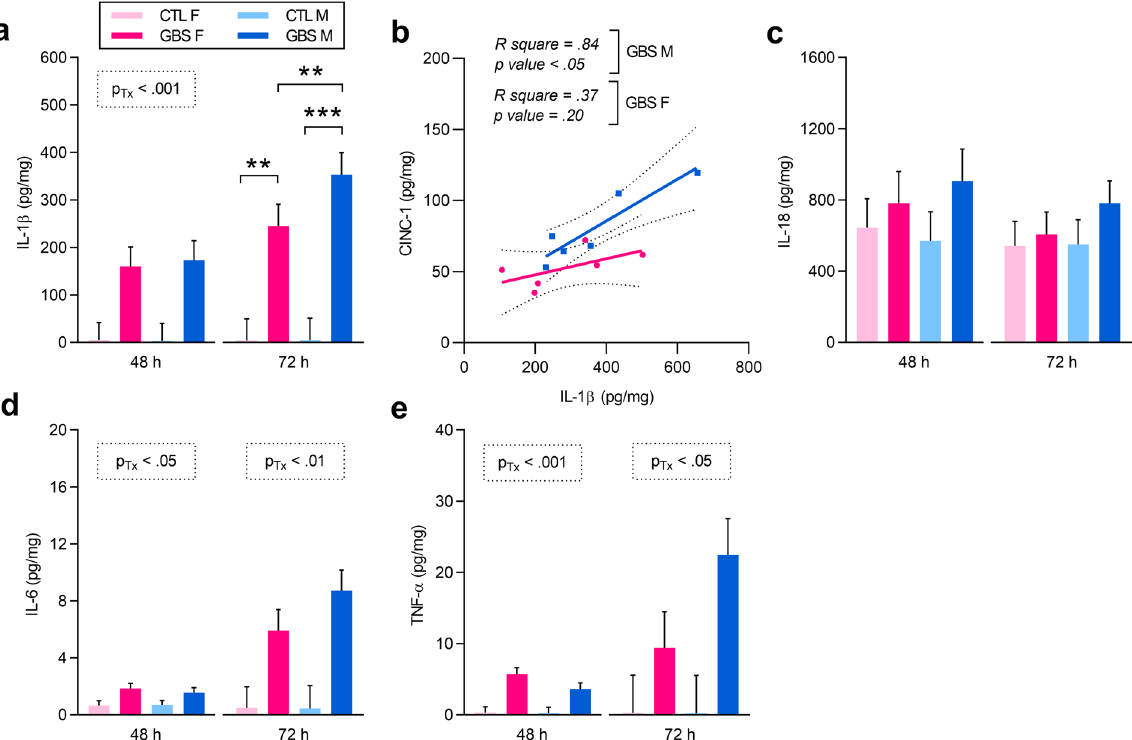
Figure 4. GBS-infected placentas displayed a sex dichotomous pro-inflammatory profile. ( a ) Mean concentration of IL-1 β in placentas at 48 and 72 h quantified by ELISA. Comparisons between GBS-infected versus CTL placentas by linear mixed model, with Sidak’s multiple comparisons when the interaction between sex and treatment was significant. ** P < 0.01, *** P < 0.001. ( b ) Correlation between levels of IL-1 β and CINC-1/CXCL1 at 72 h post-injection. The within-subject correlation between IL-1 β and CINC-1 levels was analysed by linear regression. ( c – e ) Mean levels of IL-18 ( c ), IL-6 ( d ) and TNF- α ( e ) detected in placentas at 48 and 72 h post-injection by ELISA. Analyses were done by linear mixed model and significant results are shown in the dashed box. Bars represent mean ± SEM. Number (n) of placentas: n = 4 [48 h] and n = 6 [72 h] per sex in the GBS group, and n = 5 [48 h] and n = 5 [72 h] per sex in the CTL group. One male and one female placentas were used per litter. Abbreviations: CTL, Control; CINC-1, Cytokine-Induced Neutrophil Chemoattractant 1; F, Female; GBS, Group B Streptococcus ; h, hour; IL, Interleukin; M, Male; TNF- α , Tumor Necrosis Factor- α ; Tx,